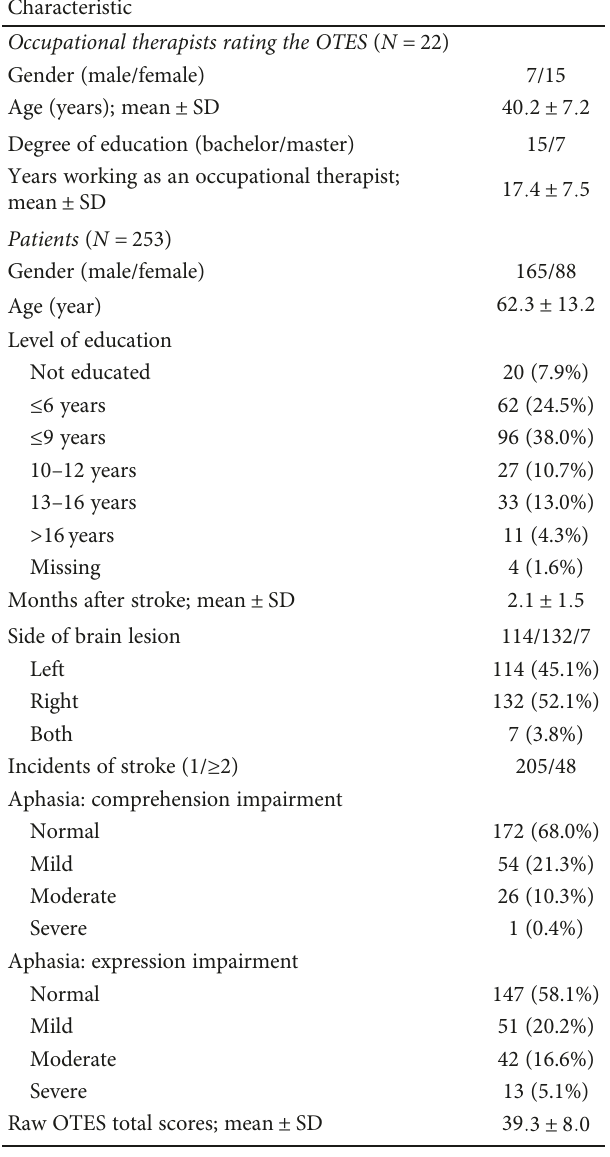
Table 1: Demographic and clinical characteristics of the patients and occupational therapists rating the